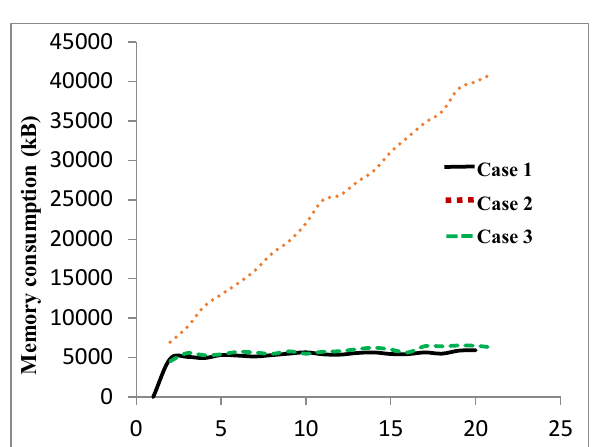
Figure 12 . A used amount of the memory in the adaption